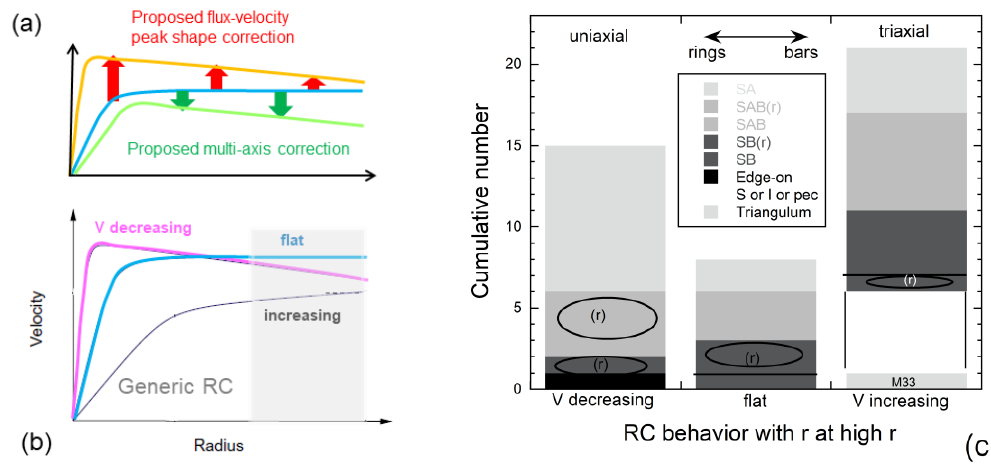
Figure 7. Evaluation of RC for possible multiple spin axes: ( a ) Schematic of how systematic errors will affect rotation curves. Blue = typical measured RC with a flat trend. Red arrows = corrections for asymmetric peaks in flux-velocity profiles. Green arrows = corrections for a 2nd spin axis. Both effects make the slopes of rotation curves decrease more strongly at high radius, as shown in the orange and green RC; ( b ) Simplified representation of commonly observed rotation curve types, after the classification scheme used by Wiegert and English [61] and others. Gray rectangle = the galactic region used to determine the d V /d r ; ( c ) Histogram of the list of non-interacting galaxies in Table 3 of [61]. Types with a ring are indicated by (r) and an ellipse. The box shows the morphological types. The double arrow indicates that d V /d r being negative correlates with axial symmetry, but anti-correlates with symmetry lowering elements such as bars.